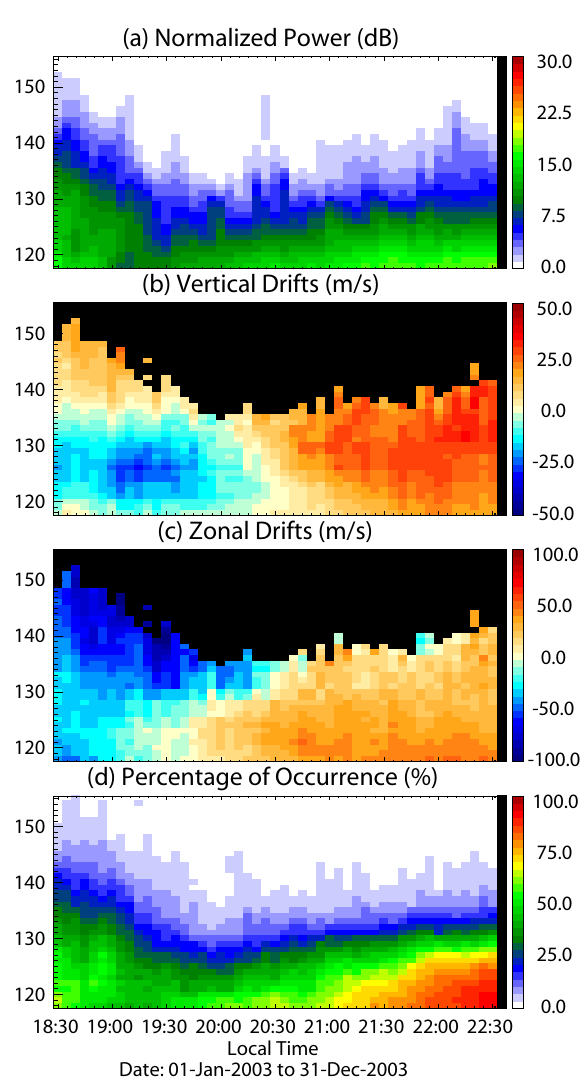
Fig. 2. Statistical results based on 204 days of single-baseline inter- ferometry observations in 2003. (a) Normalized power, (b) Doppler velocities, (c) zonal drifts, and (d) percentage of